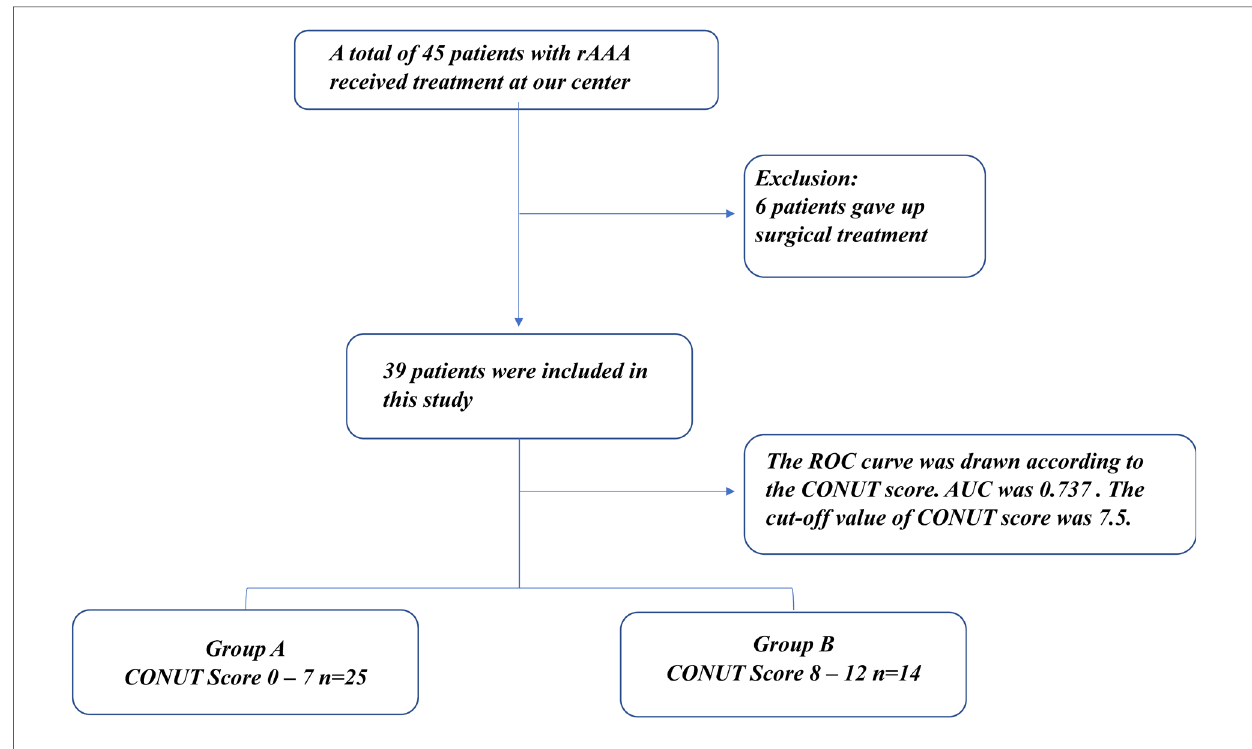
FIGURE 1 Flowchart of patients.